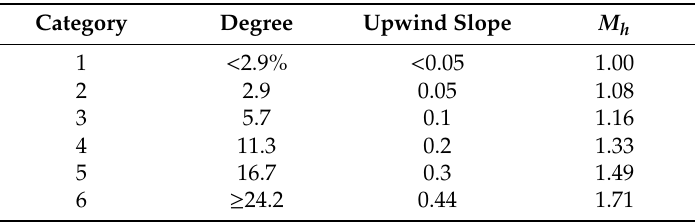
Table 3. Hill shape Multiplier ( M h